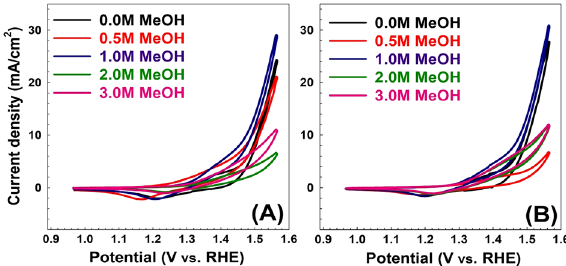
Figure 6. Cyclic voltammetry of as prepared samples ( A ) before and ( B ) after MO adsorption for different methanol oxidation at 50 mV/S scan rate.